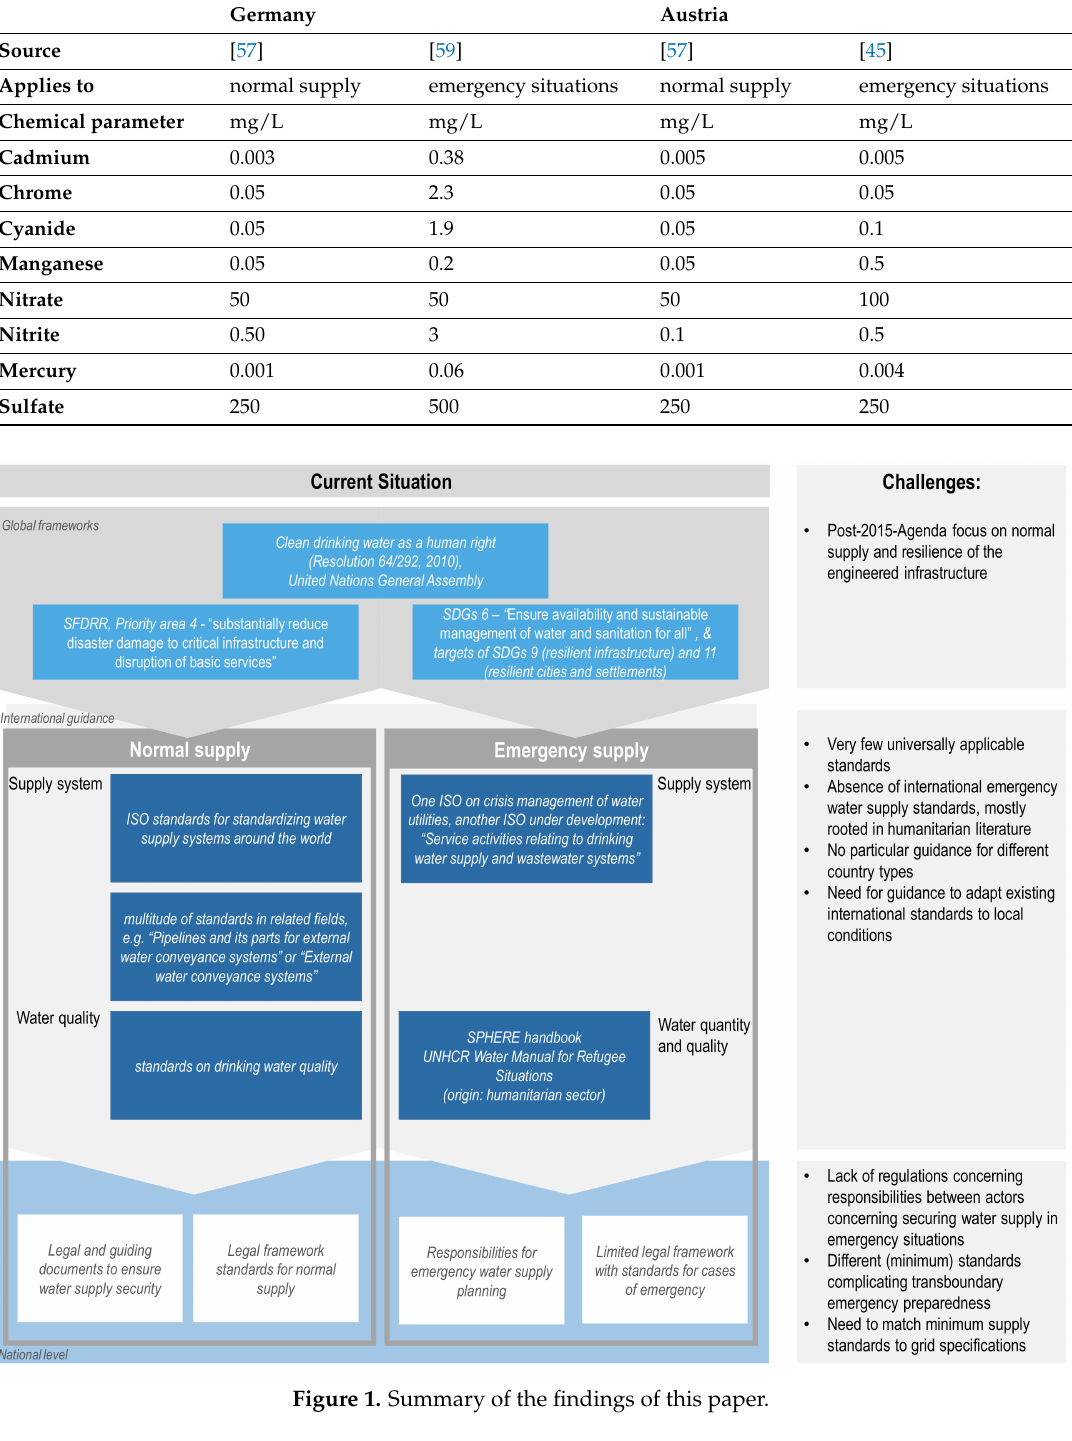
Table 4. Extract of differences in relevant qualitative minimum supply standards in Germany and Austria under normal and emergency conditions.